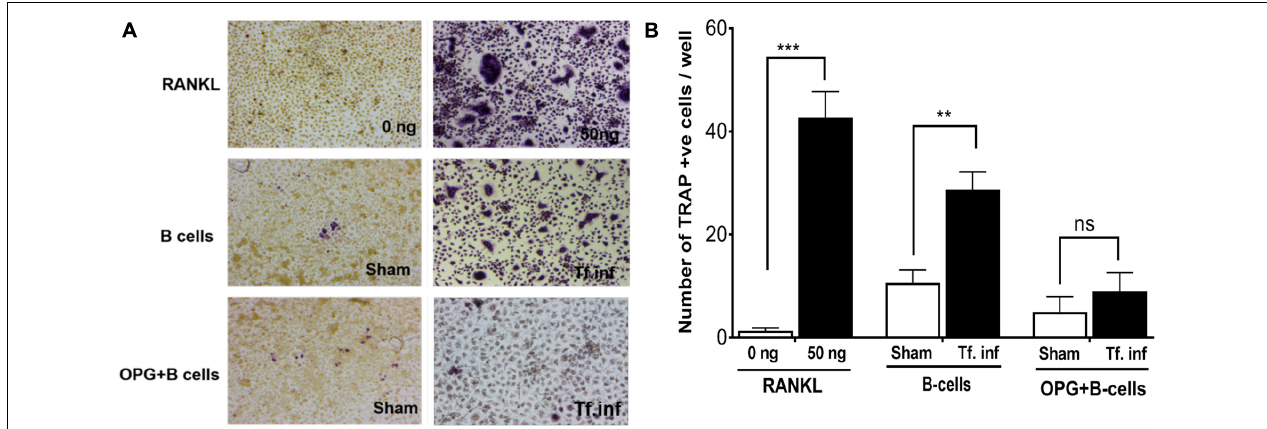
FIGURE 3 | T. forsythia causes osteoclastogenesis via induction of RANKL + effector B cells. Evaluation of osteoclastogenesis in vitro by TRAP staining. CD19 + ve B cells from mice were co-cultured with bone marrow derived macrophages. In some condition’s co-cultures were performed in the presence of mouse OPG-Fc at a concentration of 10 µ g/mL to confirm the osteoclastogenesis is mediated by RANKL-RANK interaction. TRAP staining was performed to determine the number of multinucleated osteoclasts. (A) Representative histological staining showing increased multinucleated TRAP positive cells (magenta-red) in cocultures of bone marrow derived macrophages with B cells from T. forsythia infected (Tf. Inf) versus sham infected mice. (B) Data are means ± s.d. of TRAP + cells per well for each treatment from a representative experiment performed with three replicates per condition. Inclusion of OPG in cocultures significantly reduced the number of TRAP positive cells. ** p < 0.01; *** p < 0.001.